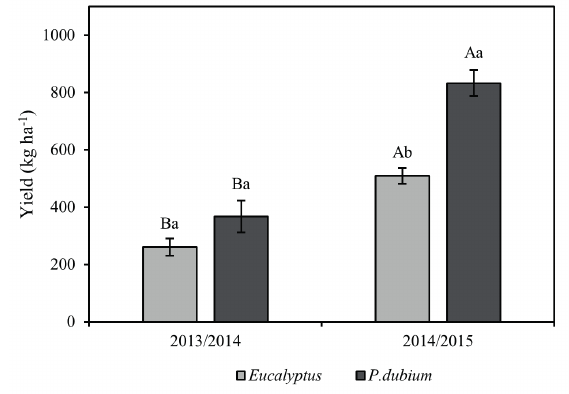
Figure 5 - Yield (Kg ha -1 ) of soybean cultivated in an agroforestry system, submitted to Eucalyptus and P. dubium during two crop years (2013/2014 and 2014/2015). Southern, Brazil. Means followed by the same letters, uppercase comparing the crop years and lowercase the forest species Eucalyptus and P. dubium , have not significant difference by the Tukey test (p<0.05). Each bars represent average values ±